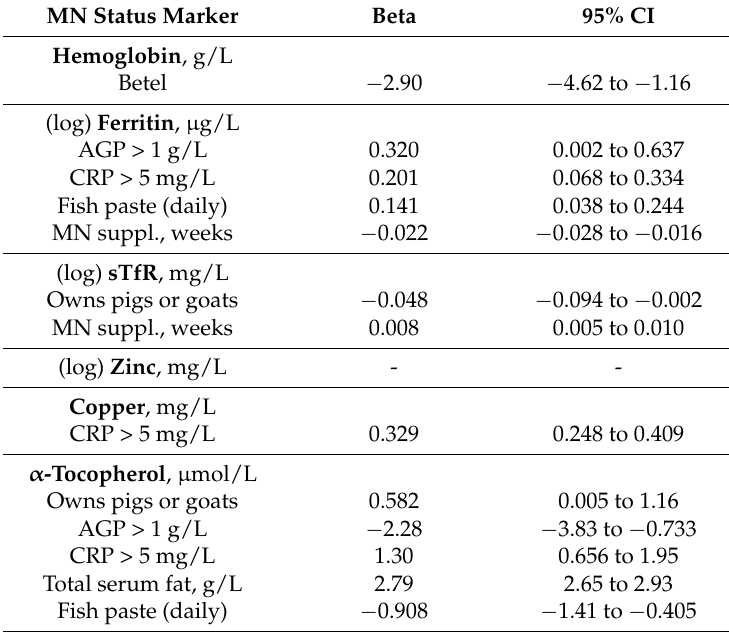
Table 5. Determinants of hemoglobin and micronutrient status marker in pregnancy 1